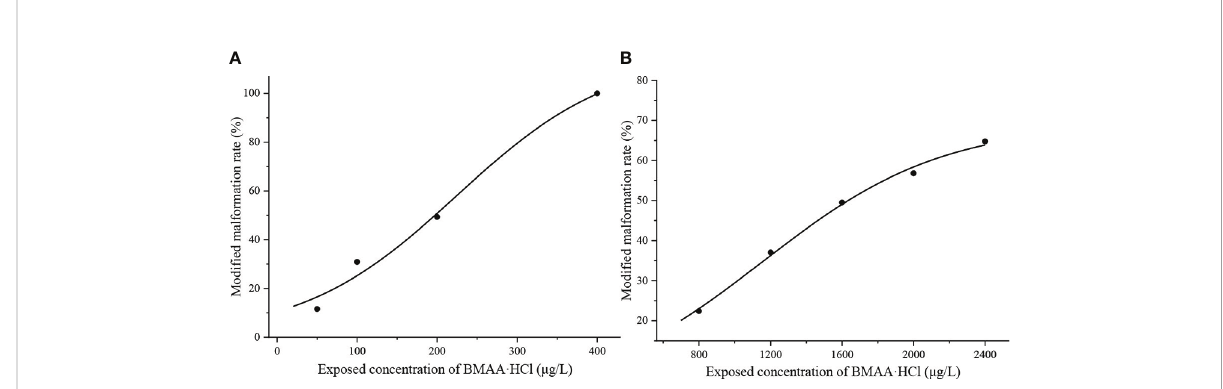
FIGURE 2 Modi fi ed malformation ratios of mussel ( Mytilus galloprovincialis ) embryos at 48 hours post fertilization (HPF) (A) and oyster ( Magallana gigas ) embryos at 24 HPF (B) during the BMAA exposure